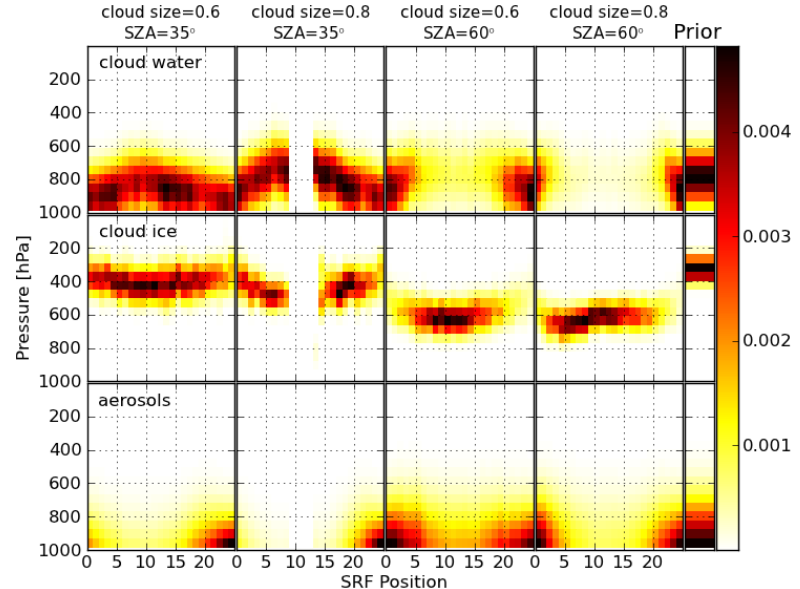
Figure 14. Retrieved optical depth profiles of atmospheric scatterers for four scenarios (cloud sizes 0.6 and 0.8km for both SZA) with the soil surface albedo. Each panel shows the profile in a vertical column, with the y axis indicating profile pressure, and the x axis indicating the SRF position. Top, middle and bottom rows show the cloud water, cloud ice, and aerosol (sum of the Khan 2b and 3b) profiles, respectively. The far right column shows the prior optical depth profiles used by the optimal estimation